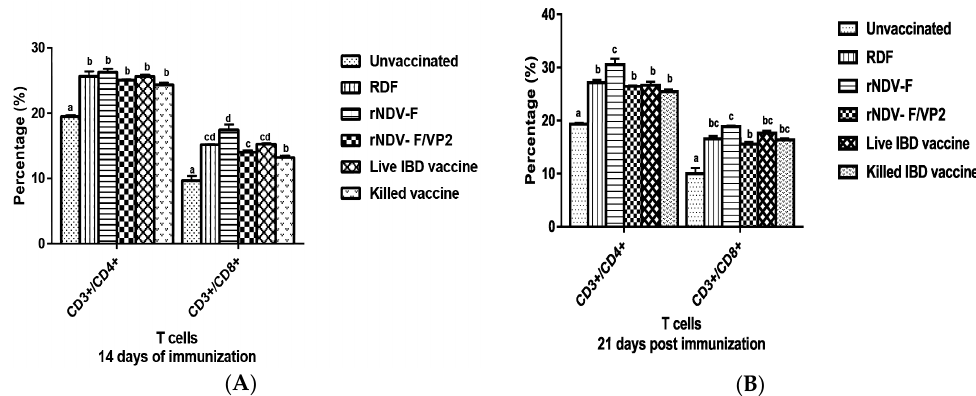
Figure 7. Flow cytometric analysis of CD4 + and CD8 + T cells in peripheral blood mono-nuclear cells (PBMCs) of vaccinated and unvaccinated birds at 14 ( A ) and 21 ( B ) dpi. PBMCs were collected from the birds and 1 × 10 5 cells were analyzed after addition of chicken specific Mabs conjugated with fluorescent dyes. Data represent the percentage of cells ± SEM. The values depicted in different lowercase superscripts differ significantly ( p < 0.01) and Waller-Duncan as post-hoc test.